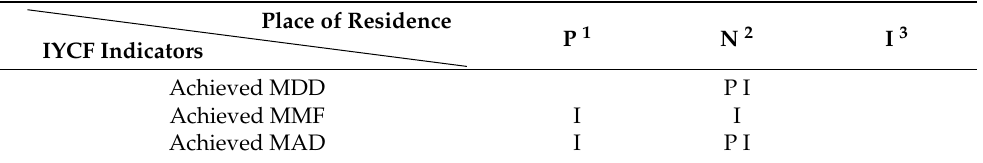
Table A2. * Multiple proportion test to compare the proportion of children meeting the WHO IYCF indicators across Paramaribo, Nickerie, and the tropical rainforest